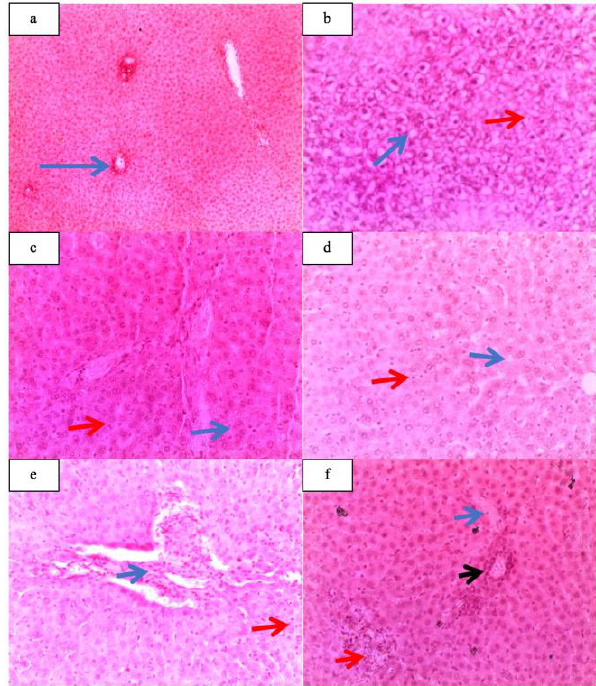
Fig. 2: Histopathological examination of rat liver(a-h): (a&b) group 6 of rats given 500mg/kg, (a) the liver shows peri- portal infiltration of Inflammatory cells around portal artery blue arrow (b) shows severe fatty changes of hepatocytes blue arrow, the proliferation of kupffer cells red arrow (c). Group 5 at 500 mg/kg shows mild degenerative changes of hepatocyte blue arrow and proliferation of kupffer cells red arrow. Group 4 at 500 mg/kg, (d) showing focal area degenerative changes of hepatocytes blue arrow and moderate proliferation of kupffer cells red arrow in (e) showing focal aggregation of inflammatory cells around the portal artery blue arrow and moderate proliferation of kupffer cells red arrow. Group 3 at 250mg/kg, showing mild focal degenerative changes of hepatocytes blue arrow, focal area of hepatitis red arrow with infiltration of inflammatory cells around of portal artery black arrow (f) H&E, 400X.